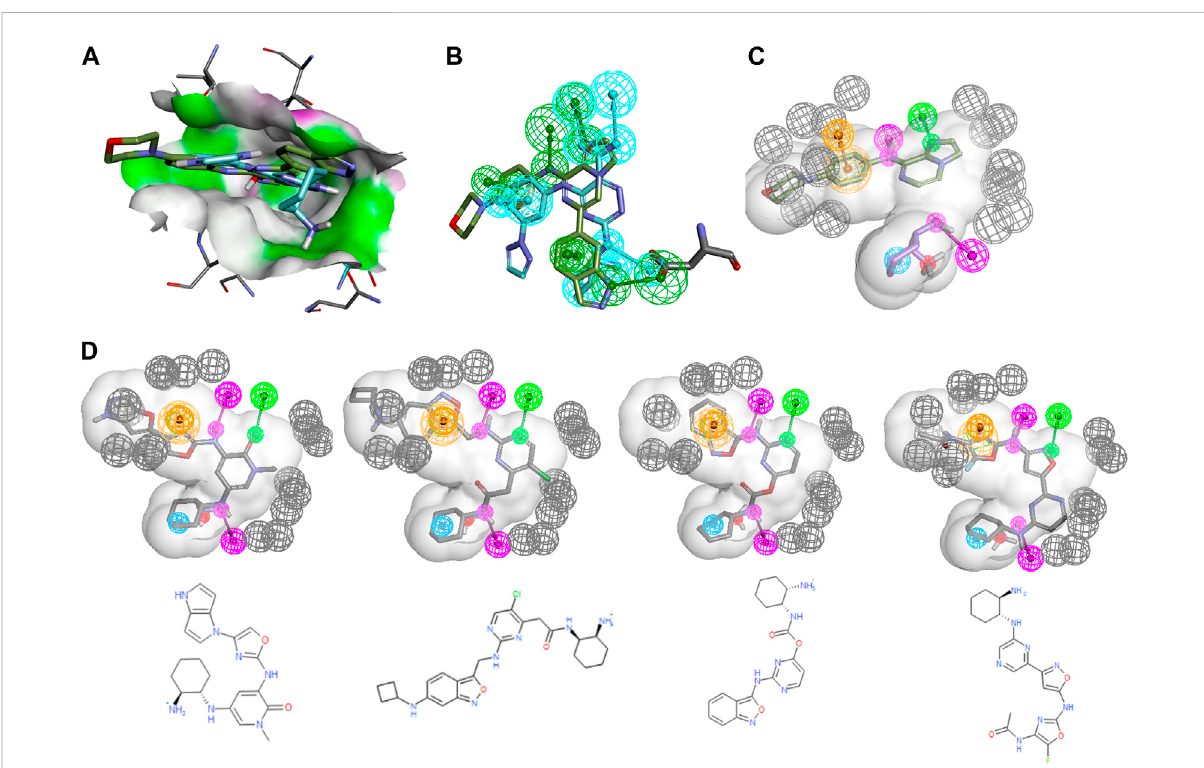
FIGURE 4 Entospletenib scaffold merging with cyclohexandiamine series. (A) PRT-062607 (cyan) and entospletinib (green) alignment using PDBid 4rxp and 4puz, respectively. Receptor surface in HBond coloring. (B) Ligands from (A) with their individual pharmacophore features (features are colored like the parent ligand). Asp512 is shown to demonstrate how ligands interact differently. (C) Hybrid PH4 with three features from each ligand (HBD magenta, HBAgreen,hydrophobecyan,ring-aromaticorange, negativechargered,exclusionvolumesgrey, formore detailseeento_portola_ 6FeaSHP2_tight + ExV in SI) and the relevant part of associated ligand. Note that feature volumes had to be reduced considerably to obtain useful results. (D) Representative GTD results aligned to PH4 model along with 2D